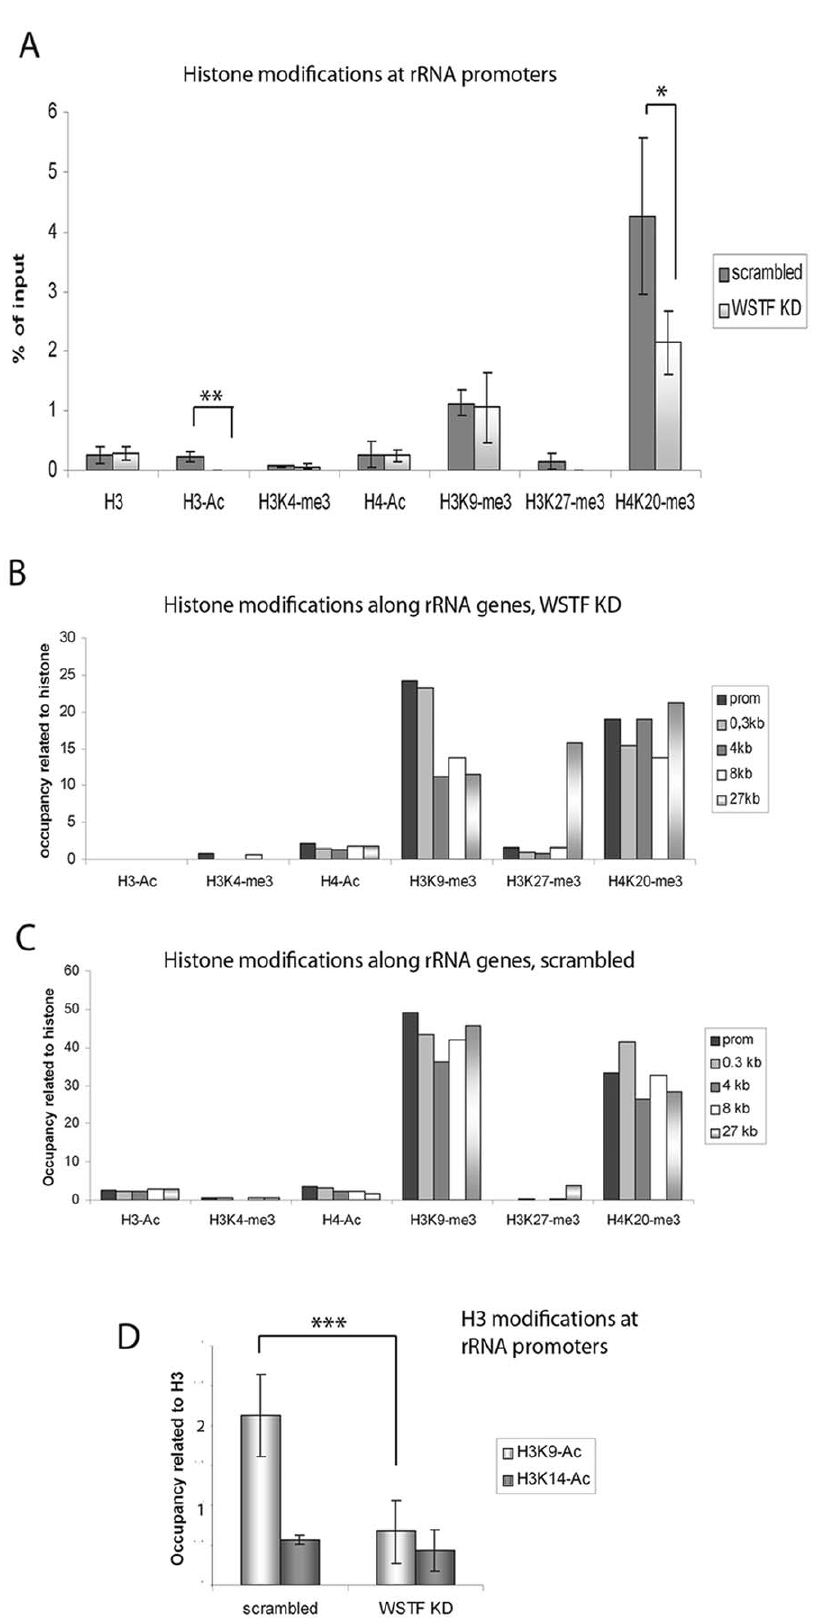
Figure 3. H3-Ac levels are reduced in WSTF KD cells. ( A ) ChIP of WSTF KD cells and scrambled control cells at the rRNA promoter with the antibodies indicated below the bars. The values are presented as percentages of the input signal. Error bars represent standard deviations from four separate experiments. **: p-value=5.5 6 10 2 5 , *: p-value=0.06 (Student t-test, two-sample equal variance). ( B and C ) ChIP of WSTF KD cells (B) and PLoS ONE |